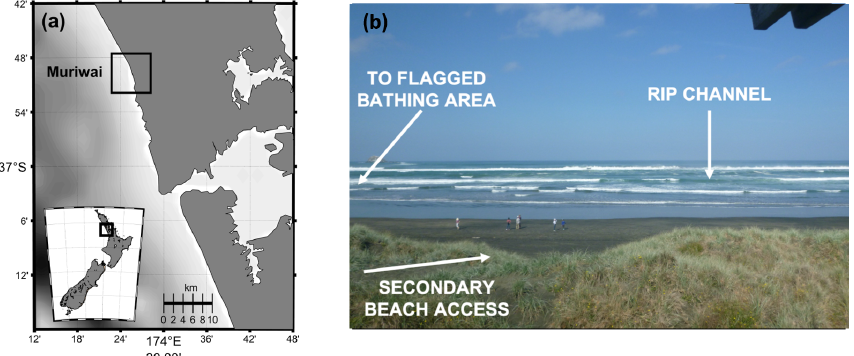
Figure 2. (a) Study site map and (b) photograph of main channel rip next to bathing area used to test rip identification ability. The photograph is taken by the lifeguard tower next to a secondary access track linking the car park to the